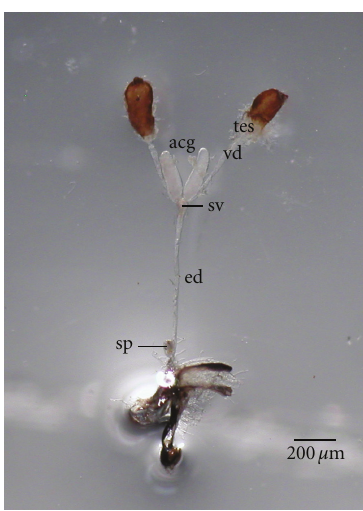
Figure 1: Whole internal reproductive tract in male C. megacephala showing paired testes (tes), paired vas deferens (vd), seminal vesicle (sv), paired accessory gland (acg), medial ejaculatory duct (ed), and sperm pump (sp).